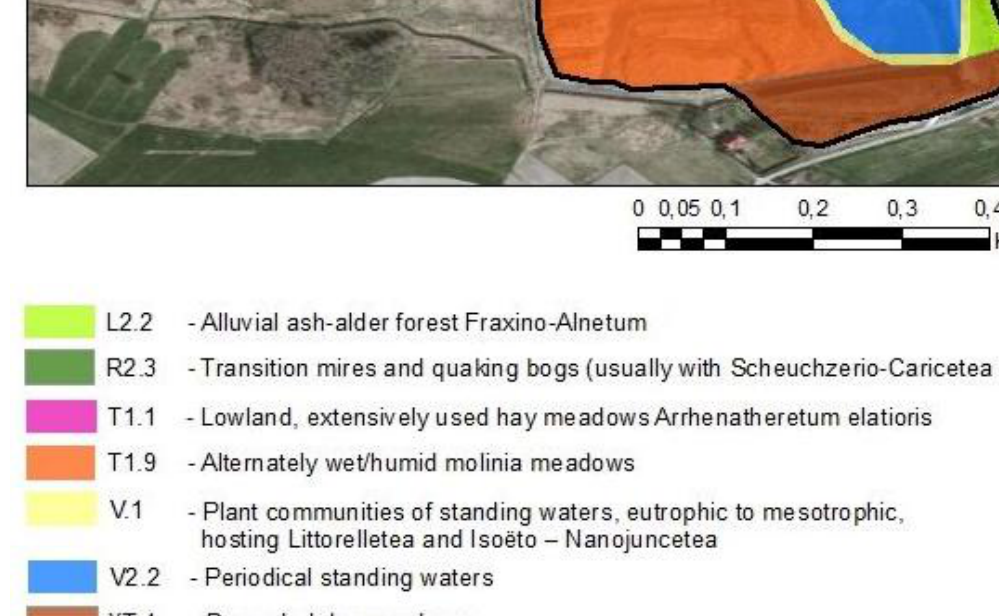
Fig. 2. Distribution of natural habitats prior to the reclamation process (source: WMS